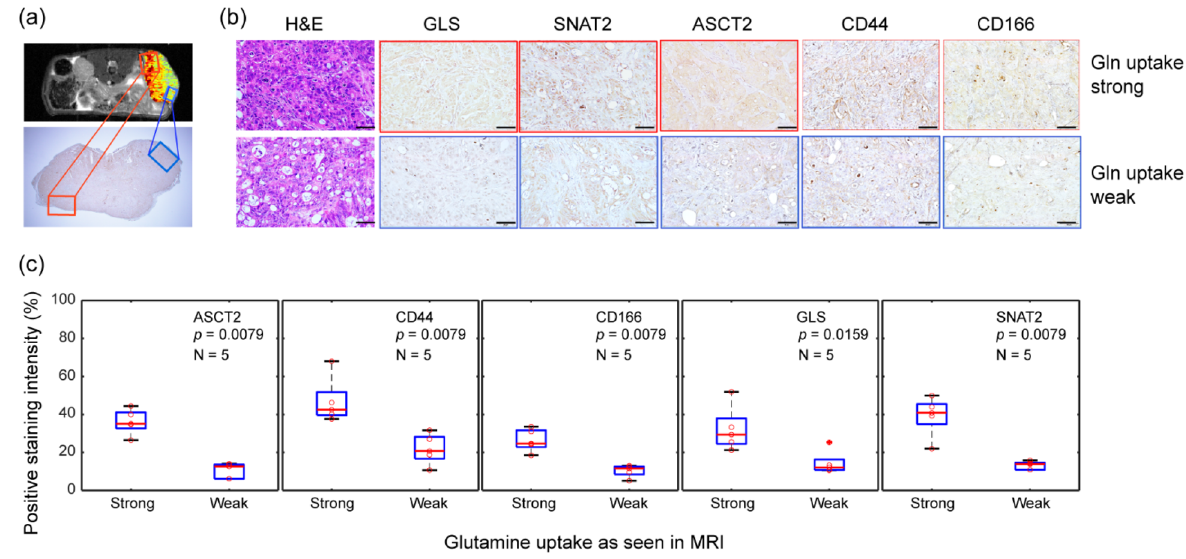
Figure 3. Correlation between glutamine uptake in magnetic resonance imaging (MRI) and the expression of ASCT2 and CSC markers. ( a ) The xenograft HT29 tumor, which showed both strong glutamine uptake (marked in red) and weak glutamine uptake (marked in blue) in the MRI image was sectioned to verify the MRI results. The image of the tumor below was obtained after IHC staining for ASCT2 expression. Scale bar = 2 mm. ( b ) IHC staining for ASCT2, GLS, SNAT2, CD44, and CD166 expression in tumor regions that show strong (top row, outlined in red) and weak (bottom row, outlined in blue) glutamine uptake. Scale bar = 50 μm ( c ) The t -test results of IHC scores (ASCT2, CD44, and CD166). (n = 5 biologically independent samples per